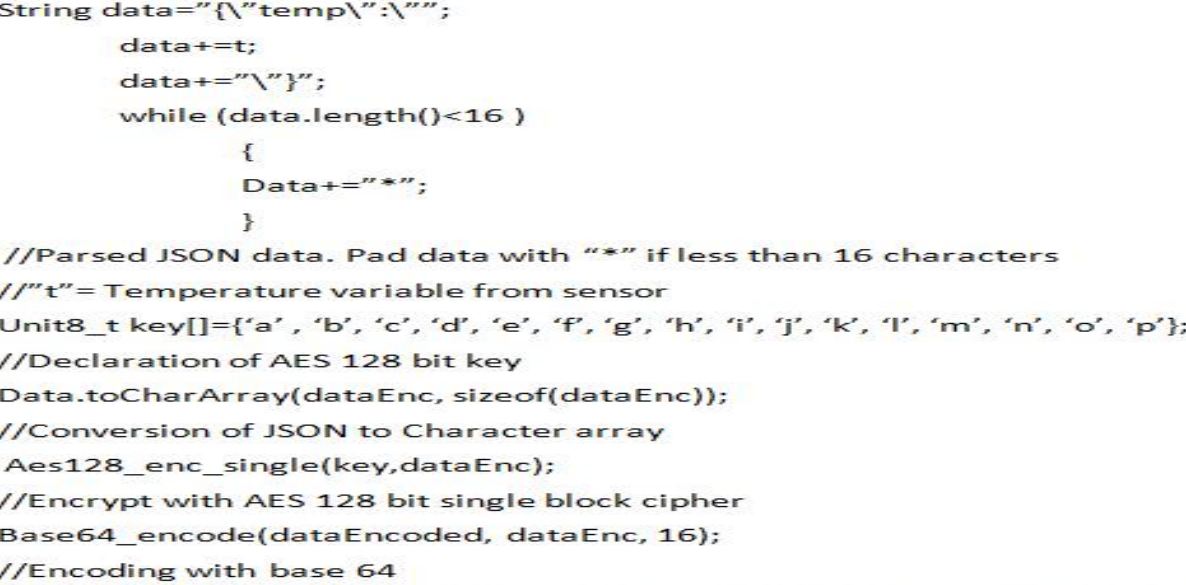
Figure 6. Code in Arduino for Data Encryption, Encoding, and JSON Data